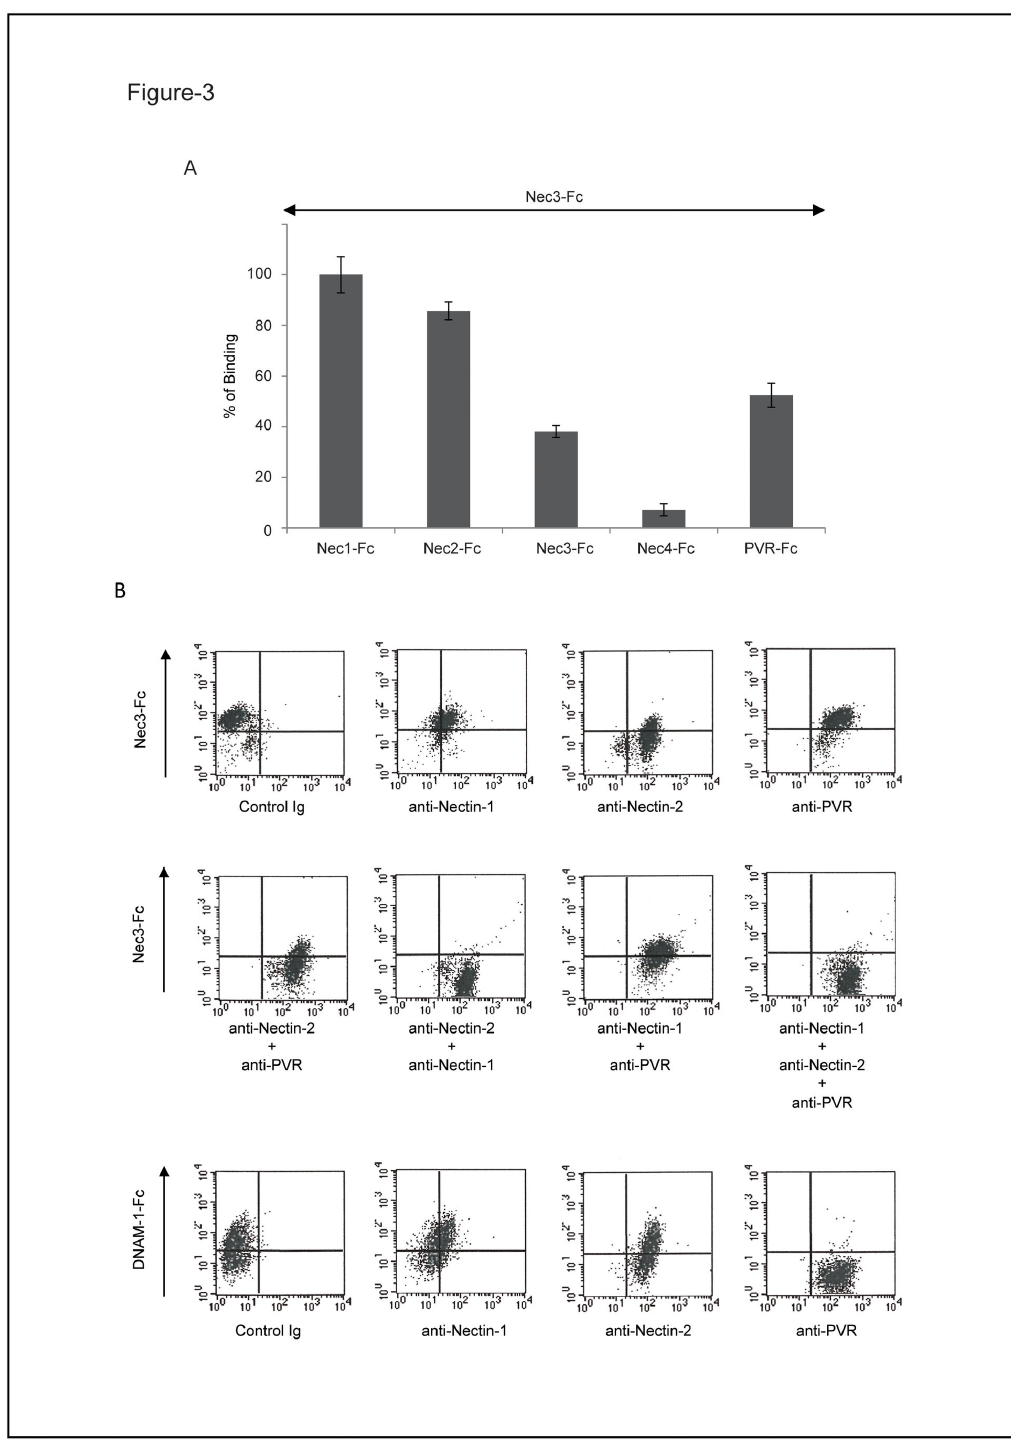
Figure 3. Endothelial Nectin-2 is the major Nectin-3 counter receptor. A : Direct binding of soluble Nectin-3 (Nec3-Fc) (10 -7 M) to indicated immobilized ligands (10 -7 M). Interactions were measured by ELISA. B : Binding of Nec3-Fc (1.5 µM) to HUVECs pre- treated with the indicated mAbs (20 µg/ml). HUVECs were either untreated or pre-treated with anti-Nectin-1 (R1.302), anti-Nectin-2 (R2.477) or anti-PVR (PV.404) mAbs alone or in combinations. Nec3-Fc and DNAM1-Fc binding to HUVECs was then analyzed by FACS. doi: 10.1371/journal.pone.0077424.g003 PLOS ONE |